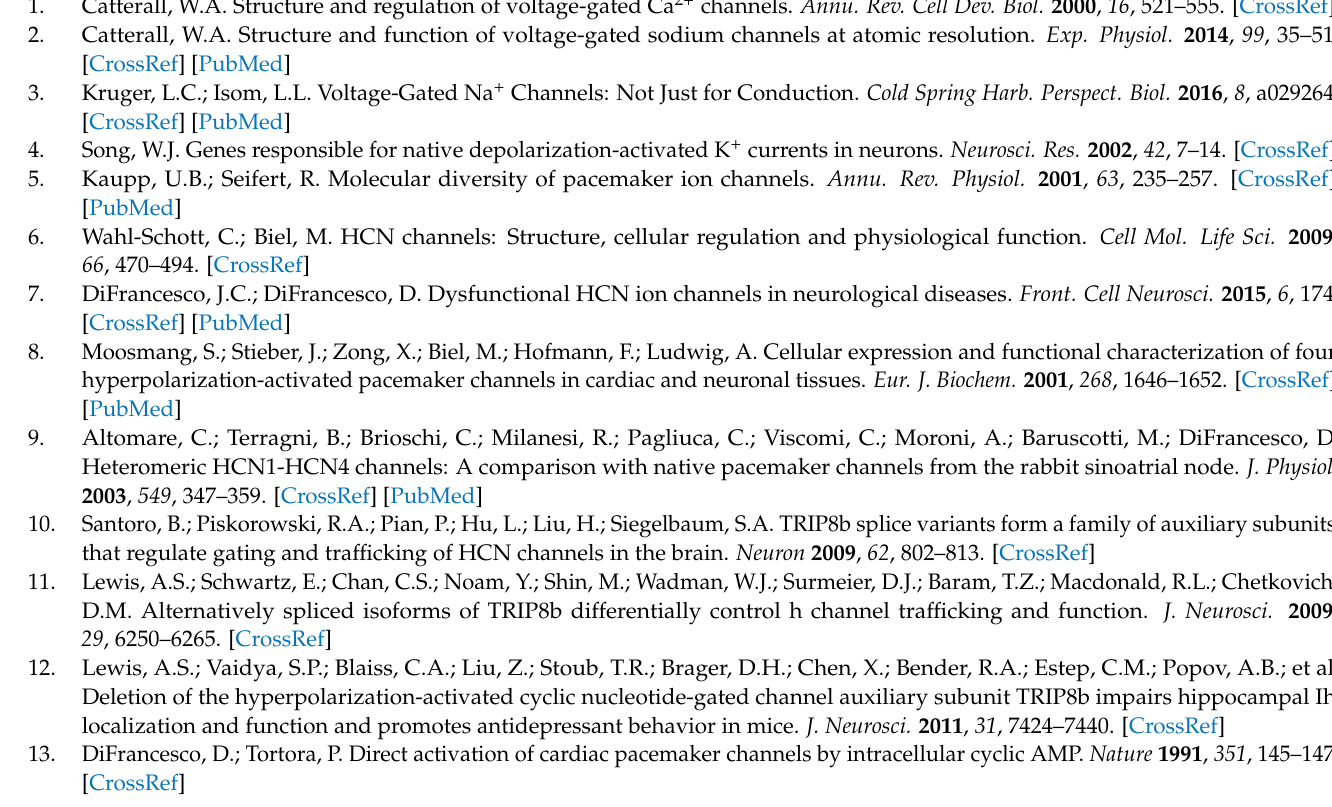
Table S2: Electrophysiological properties of hippocampal neurons and HEK293